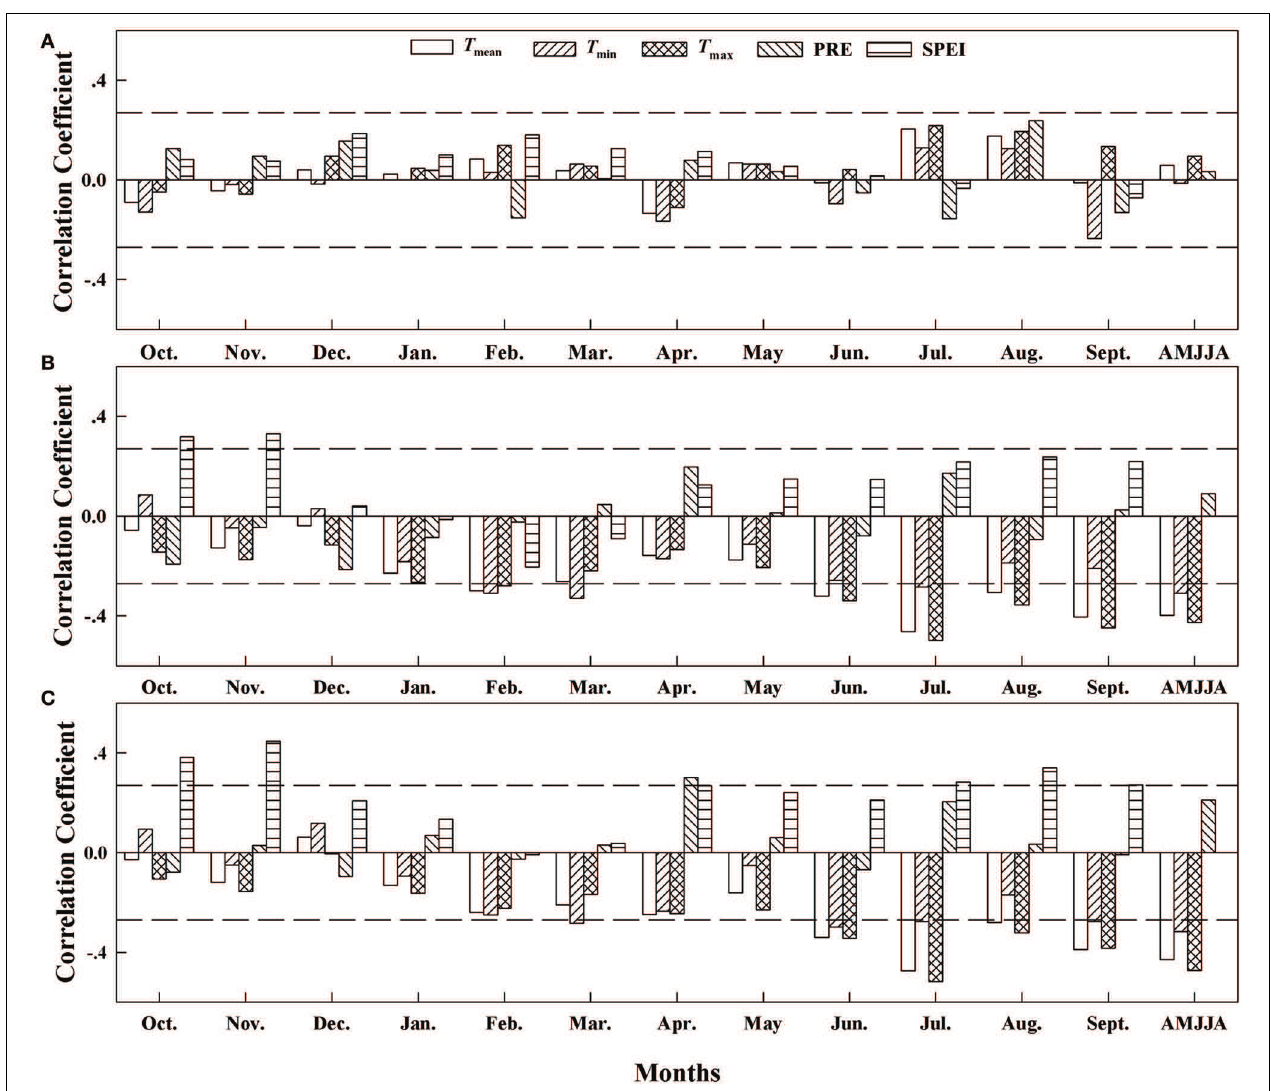
FIGURE 5 | Correlation coefficients (Pearson’s r ) between the response of the basal area increment (BAI) to the climatic variables based on data from 1960 to 2010 at (A) Site A1 (2700m a.s.l.), (B) Site A2 (2400m a.s.l.), and (C) Site A3 (2200m a.s.l.). Horizontal dashed lines